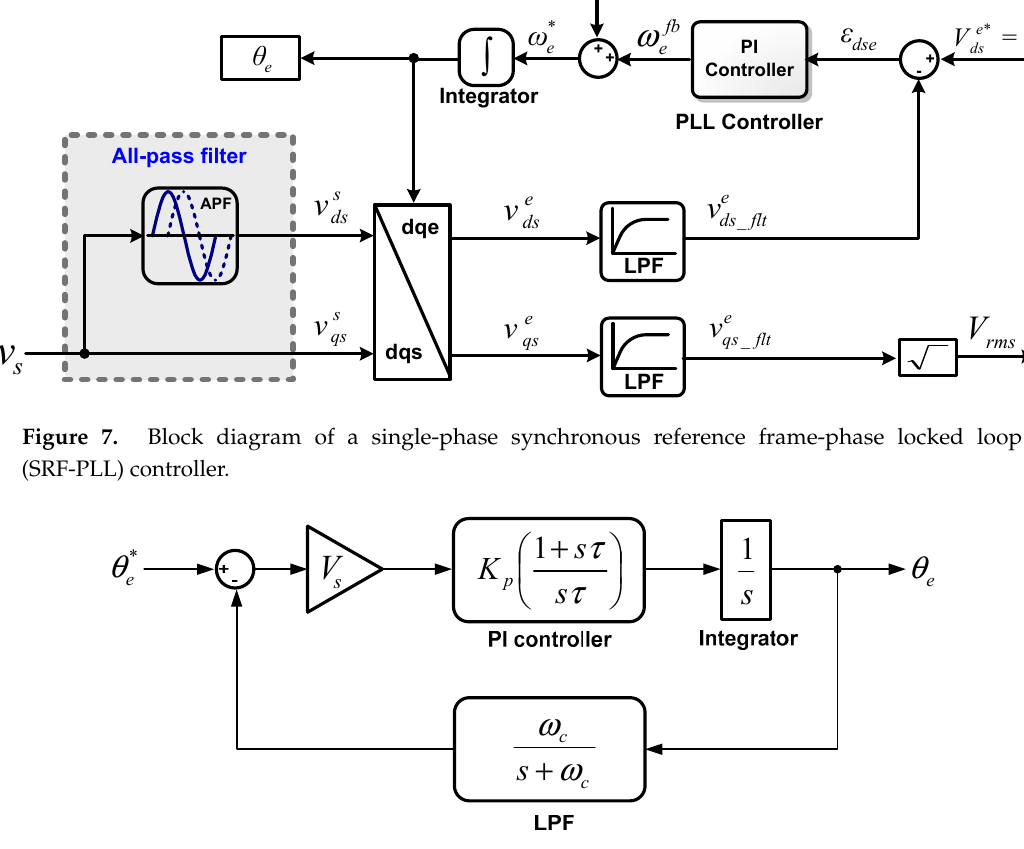
Figure 8. Modeling of PLL system with a low-pass filter (LPF).